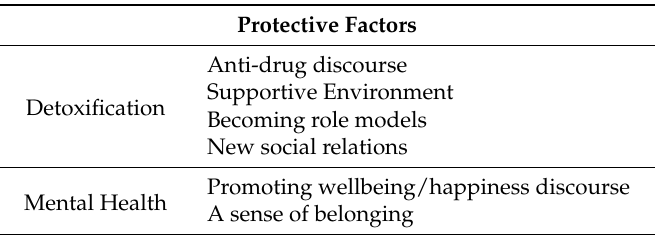
Table 2. Summary of the Protective